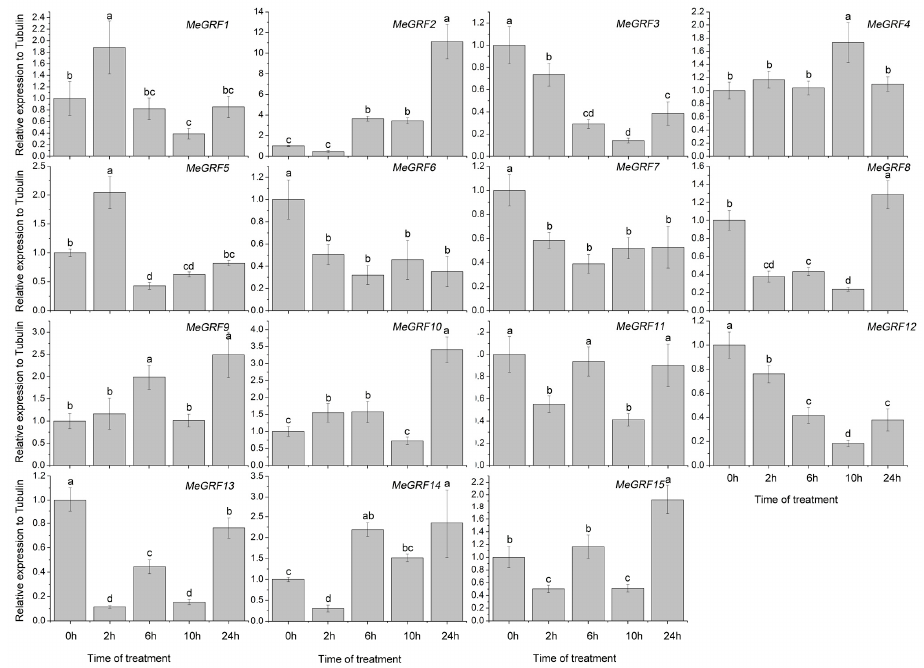
Figure 9. Expression analysis of cassava GRFs in response to H 2 O 2 treatment. The mean fold changes of each gene between treated and control samples at each time point were used to calculate its relative expression levels. NTC indicates no treatment controls (mean value = 1). Data are means ± SD of n = 3 biological experiments. Means denoted by the same letter do not significantly differ at p < 0.05 as determined by Duncan’s multiple range test.